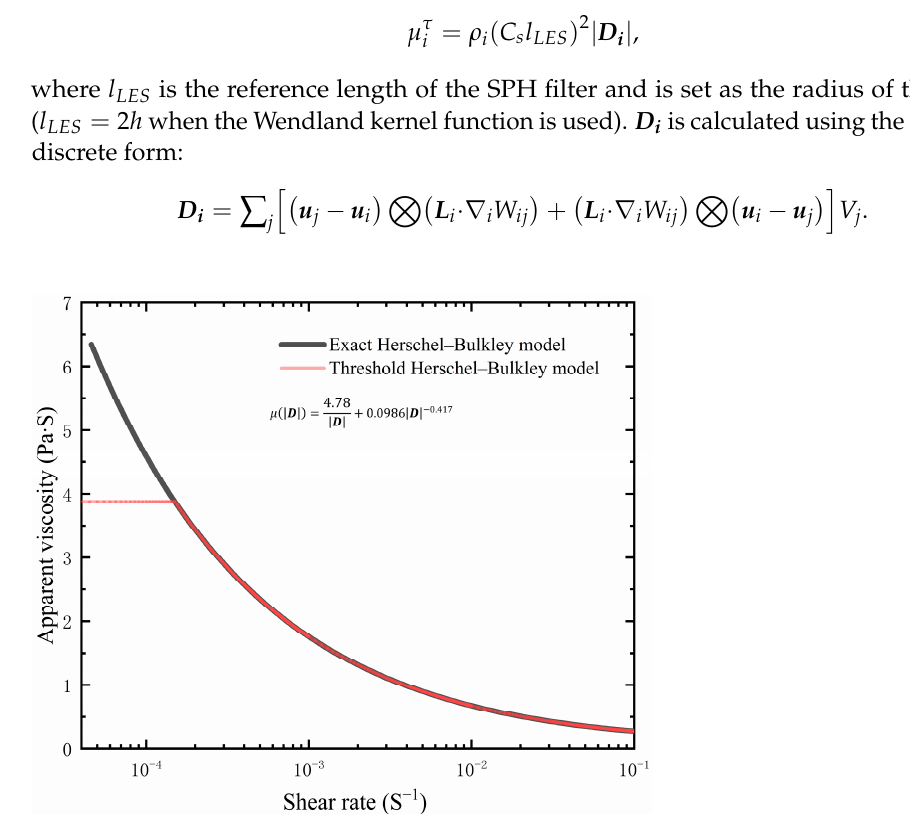
Figure 1. An example of apparent viscosity as a function of the shear rate of the Herschel–Bulkley model.